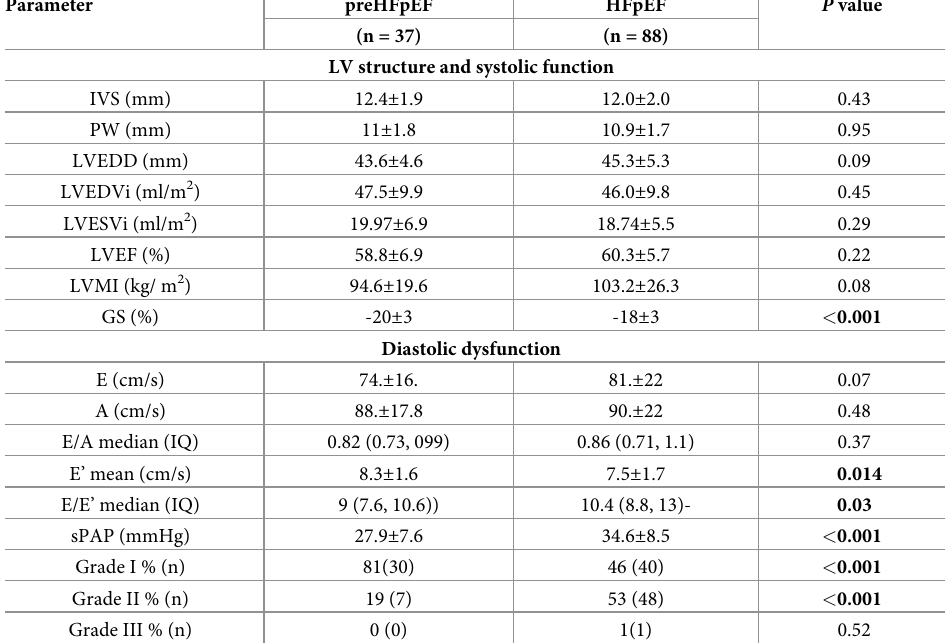
Table 2. Comparison between groups in terms of systolic and diastolic parameters.